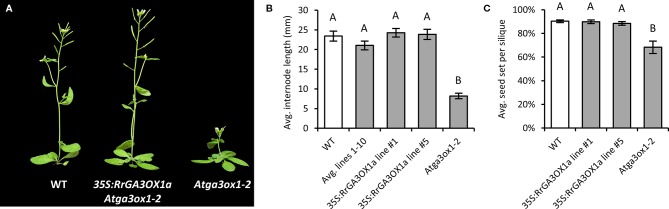
Complementation of the dwarfed stature and reduced fecundity of Arabidopsis Atga3ox1-2 by over-expressing RrGA3OX1a driven by the 35S Cauliflower Mosaic Virus promoter. For confirmation of genotype and transgene expression of the 10 independent 35S:RrGA3OX1a Atga3ox1-2 complemented lines, see Supplementary Figure S7. (A) A qualitative example showing the improved growth stature of a 35S:RrGA3OX1a Atga3ox1-2 transgenic plant (line #1) over its Atga3ox1-2 progenitor. (B) An assessment of average internode length quantifying the improved primary bolt elongation of the 35S:RrGA3OX1a Atga3ox1-2 transgenic lines. The data is presented as an average of all 10 independent transgenic lines (i.e., one random T2 transgenic plant from each line) as well as measurements from two higher expressing complemented lines (lines #1 and #5). N = 10 (WT); 10 (Avg. lines 1–10); 5 (line #1); 5 (line #5); 10 (Atga3ox1-2). There was no significant difference between the number of nodes to first flower between wild type (WT) and the complemented lines; 3.5 ± 0.1 (WT), 3.5 ± 0.2 (Avg. lines 1–10); 3.4 ± 0.2 (line #1); 3.2 ± 0.2 (line #5). At3ox1-2 produced fewer node; 2.6 ± 0.2 (Student’s t-test p < 0.05). (C)
35S:RrGA3OX1a rescues the reduced fecundity of Atga3ox1-2. Seed set per silique = seed/(seed + unfertilized ovules). N = 10 siliques for each genotype. There was no significant difference in the number of ovules per pistil produced by the different genotypes; 45.90 ± 1.49 (WT); 45.80 ± 0.93 (line #1); 44.20 ± 1.48 (line #5); 48.20 ± 1.44 (Atga3ox1-2) (Student’s t-test p > 0.05). Letters above bars in (B, C) represent a pairwise statistical comparison between categories. Categories marked with a given letter are statistically different from categories marked with another letter (Student’s t-test p < 0.05). Error bars are S.E.M.